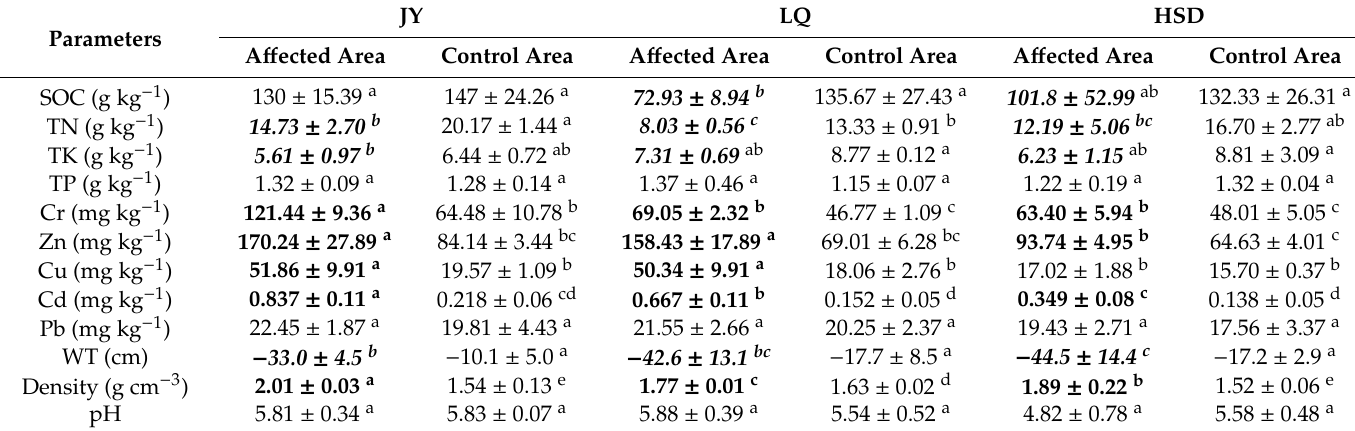
Table 1. Physicochemical attributes of soil samples taken from a ff ected and control areas of JY, LQ and HSD sites ( n = 18).